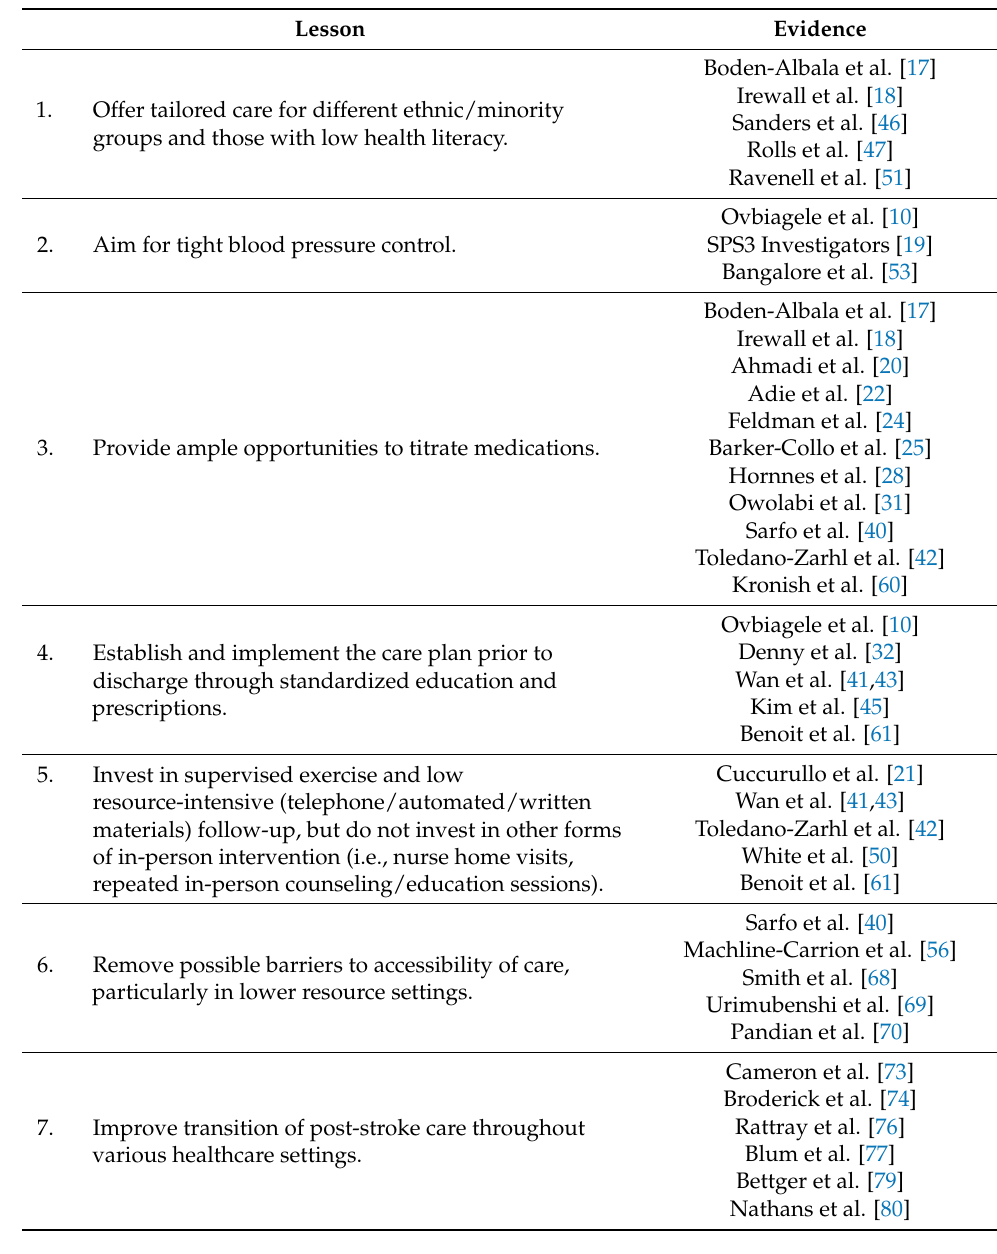
Table 2. Summary of Lessons